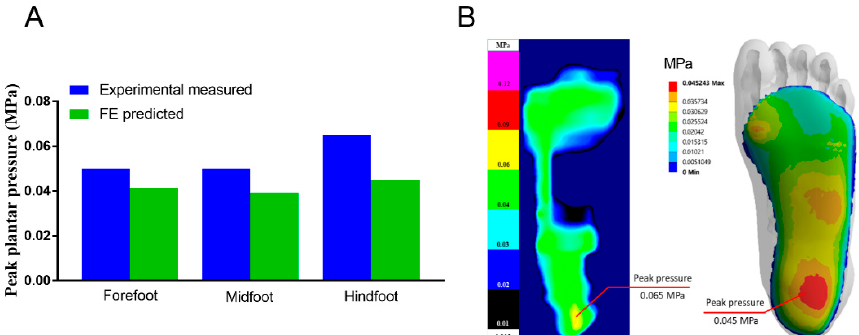
Figure 3. Validation of plantar pressure: ( A ) peak contact pressure results and experimental results from forefoot, midfoot and hindfoot during balanced standing on CMI fabricated from EVA and ( B ) plantar pressure mapping from the experimental measured and finite element predicted values with CMI fabricated from EVA.